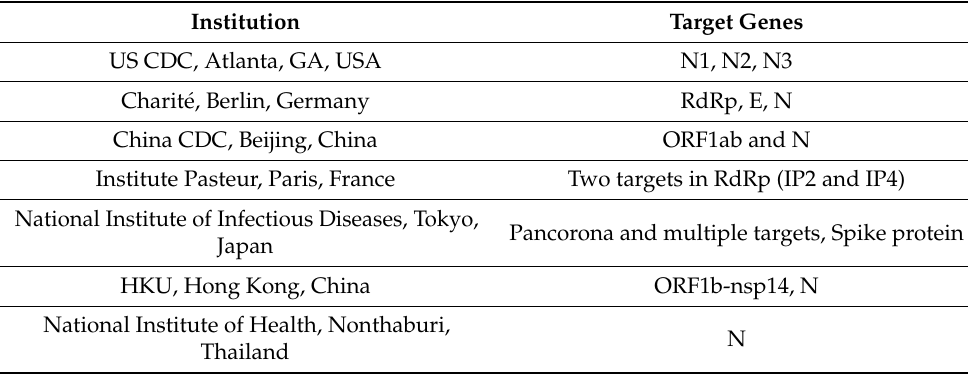
Table 2. Recommended genes for SARS-CoV-2 RT-qPCR assays. (Adapted from